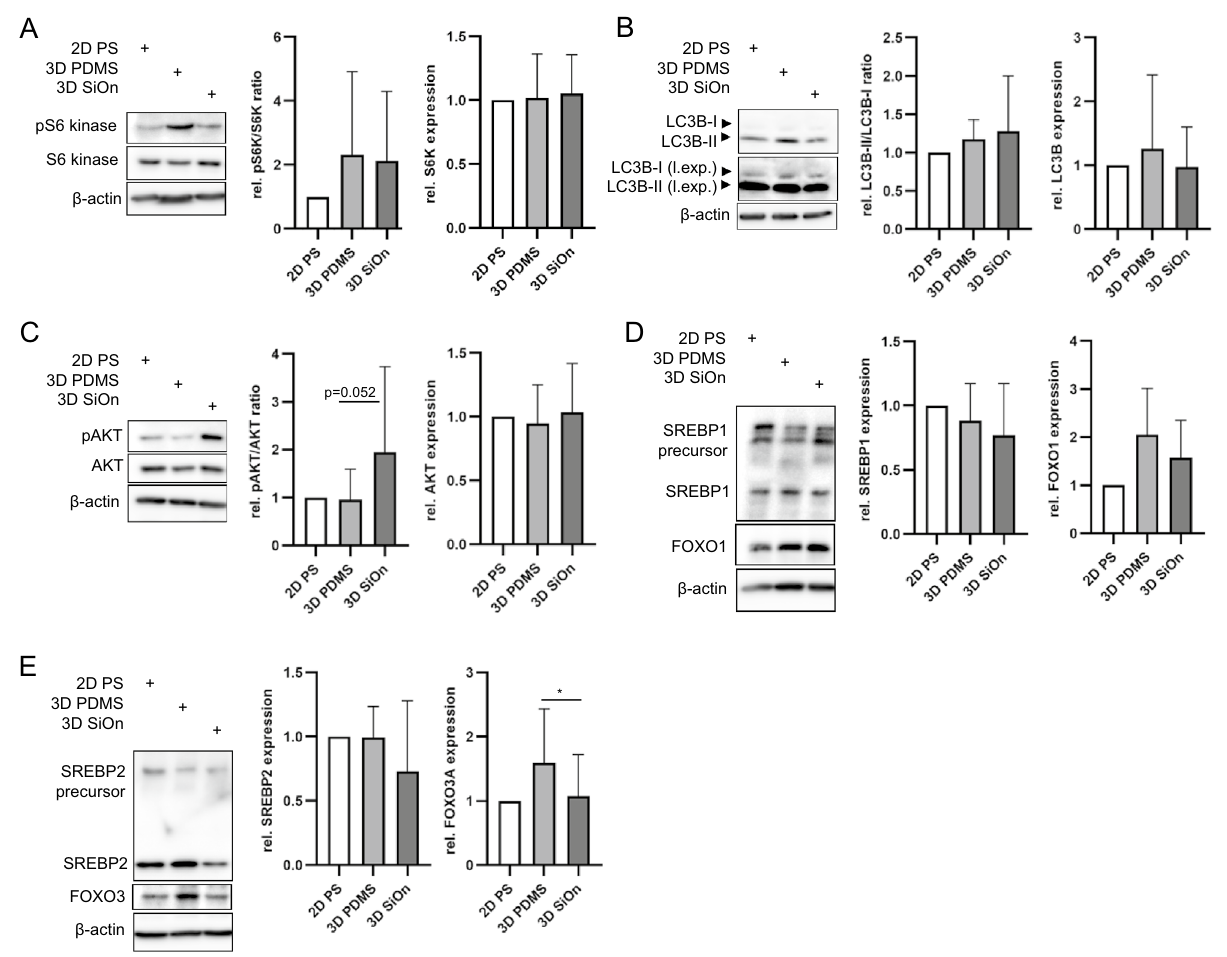
Figure 4. Human HSCs were cultivated for 14 days in vitro on 2D PS, 3D PDMS and 3D SiOn to expand high amounts of undifferentiated HSCs ex vivo. ( A – E ) After 14 DIV, the expression of indicated proteins was analyzed by Western blot. β-actin was used to control equal protein loading. ( A , C ) represent the average of 8 individual donors ± SD; ( B ) represents the average of 5 individual experiments ± SD; ( D , E ) represent the average of 4 individual donors ± SD. (l.exp.) indicates long exposures of immunoblots. Statistical significances of data were tested using a two-tailed paired parametric t-test of 8 donors in ( C ) and 4 donors in ( E ). Statistics for this figure: * p <